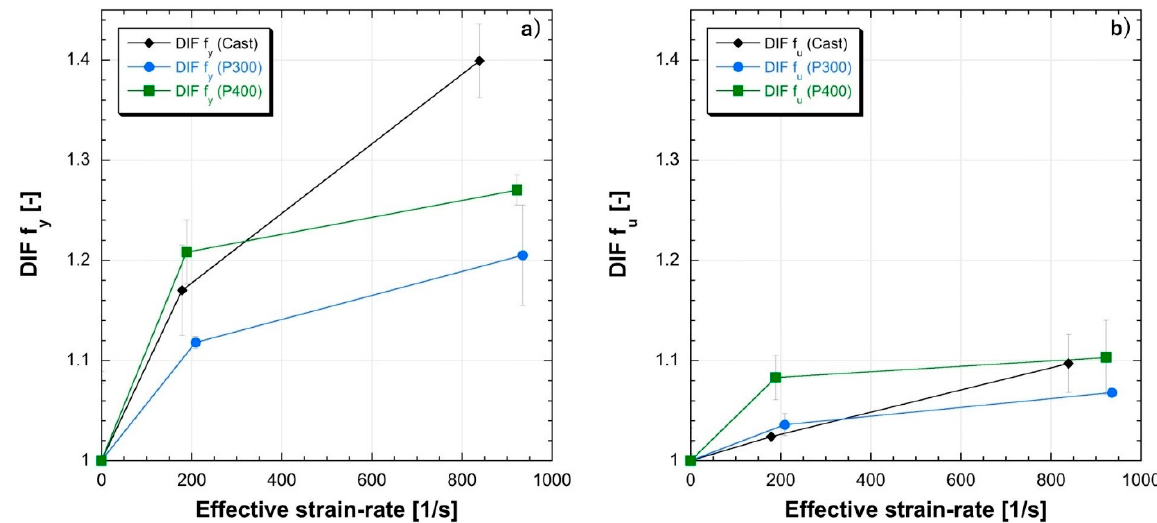
Figure 15. Dynamic Increase Factors for ( a ) YS (DIF f y ) and ( b ) UTS (DIF f u ).